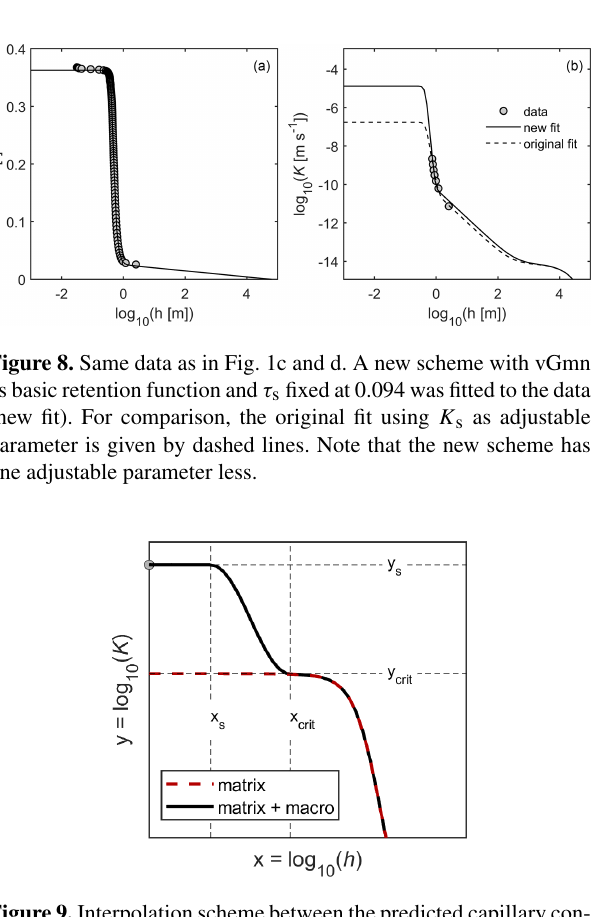
Figure 9. Interpolation scheme between the predicted capillary con- ductivity (red dashed line) and the measured value of K s (gray